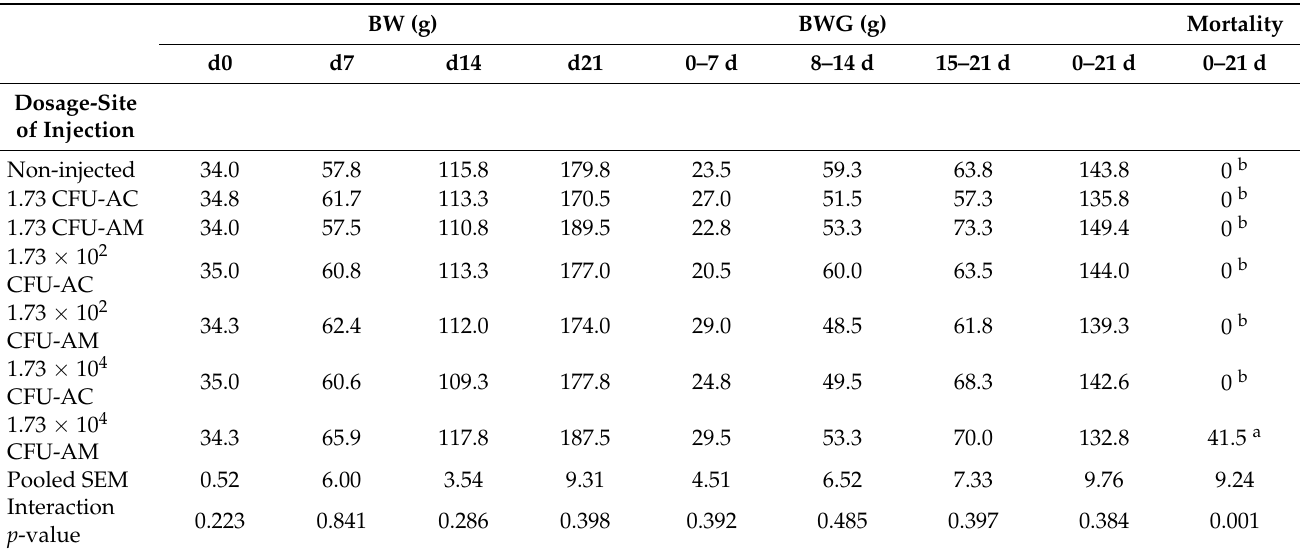
Table 8. Means of body weight ( BW ) at 0 ( BW 0), 7 ( BW7 ), 14 ( BW14 ), and 21 ( BW21 ) days ( d ) posthatch; BW gain ( BWG ) between 0 and 7 ( BWG0-7 ), 7 and 14 ( BWG7-14 ), 14 and 21 ( BWG14- 21 ) and 0 and 21 ( BWG0-21 ) d posthatch; and total chick mortality through d 21 posthatch 1 in non-injected eggs or eggs injected in the air cell ( AC ) or amnion ( AM ) with various 6/85 MG